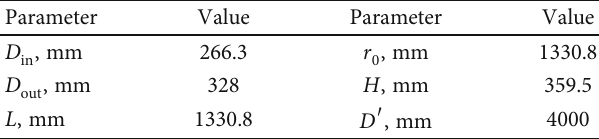
Figure 1: The computational model in the present study. Table 1: Geometric dimensions of computational